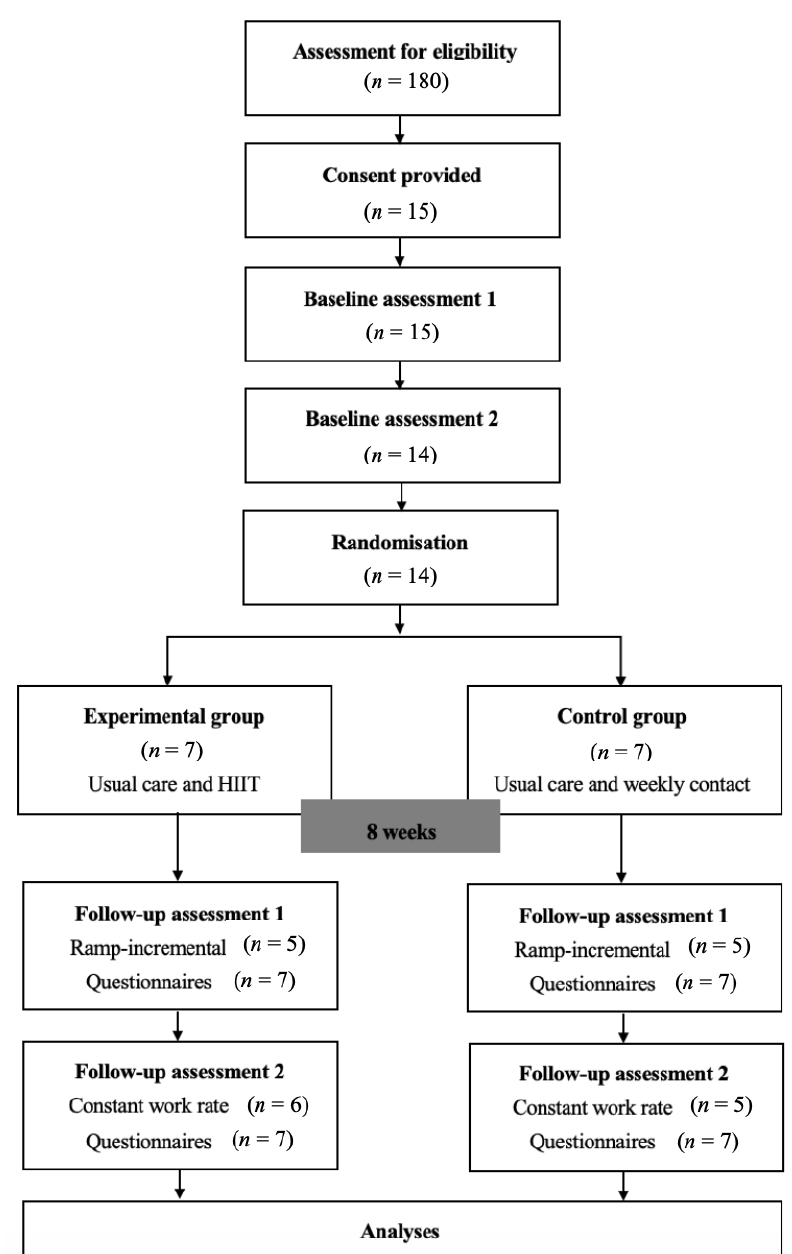
Figure 1. Study flow diagram. Notes: During the first baseline and follow-up assessments, the maximal incremental ramp-based cycle ergometry test was performed. During the second baseline and follow-up assessment, the constant work rate cycle ergometry test was performed. Questionnaires were completed across all assessment sessions. There were 180 people under the care of the CF center at Sir Charles Gairdner Hospital. Forty-one (23%) were ineligible to participate as they either lived outside the Perth metropolitan area ( n = 40) or were unable to read and understand English ( n = 1). Of the remaining participants ( n = 139), 124 declined to participate. Reasons cited for non-participation included: not willing to travel to hospital locations ( n = 59); ongoing medical issues limiting participation ( n = 29); already exercising at least twice per week ( n = 14); and being time-poor, or having a work schedule that did not permit participation ( n = 7). Four potential participants declined without a specific reason. A further nine potential participants expressed interest in the study, but did not respond to subsequent contact attempts. Two potential participants who were colonized with nontuberculous mycobacteria expressed interest in the study, but were not permitted to take part due to the risk of cross-infection in the exercise laboratory. HIIT: high-intensity interval training.